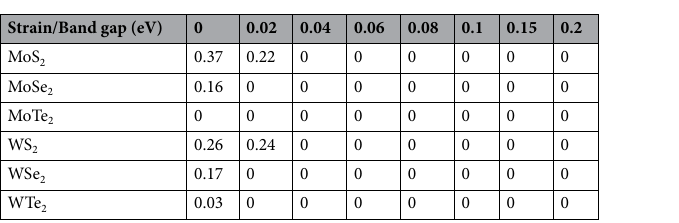
Table 2. Band gap variation of X-Tensile strain.